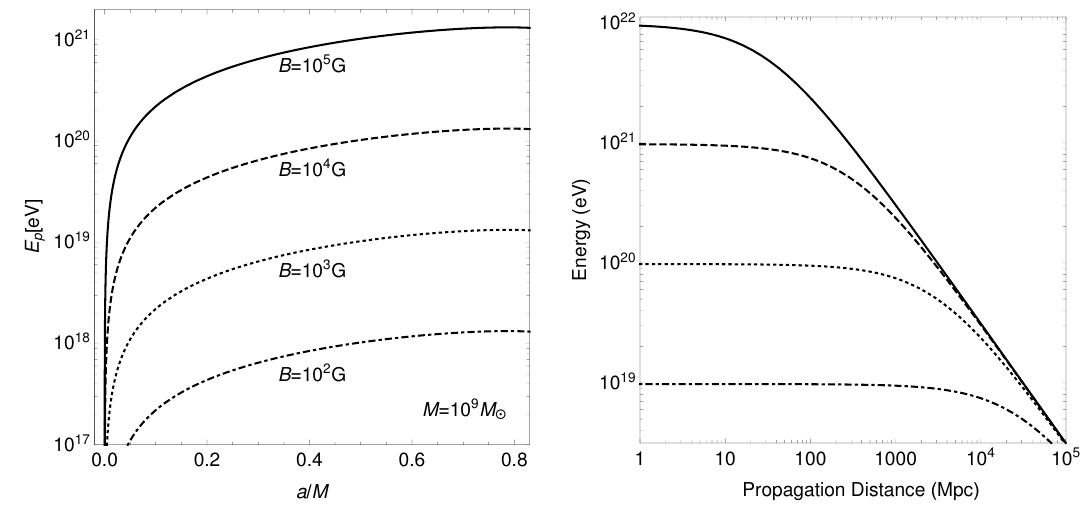
Figure 19. Creation of Ultra-High-Energy Cosmic Rays. The left figure demonstrates the dependence of energy of protons accelerated by the MPP in the field of magnetized supermassive black hole with fixed mass in dependence on its spin and the intensity of the magnetic field. The right figure reflects a decrease of the proton energy due to the radiation reaction force working during its long-distance motion in weak intergalactic magnetic field with strength B 10 − 5 G. Notice that the energy decrease ∼ is similar to those related to the GZK